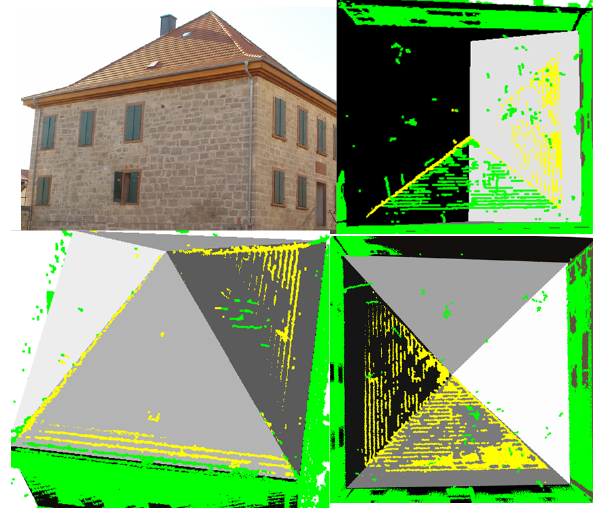
Figure 6: Top row: Image and MMSE fit using a gable roof type. The model is viewed from inside the building. Bottom row: MMSE fit using a pinnacle roof model. The model is viewed from outside (left) and inside (right) the building.